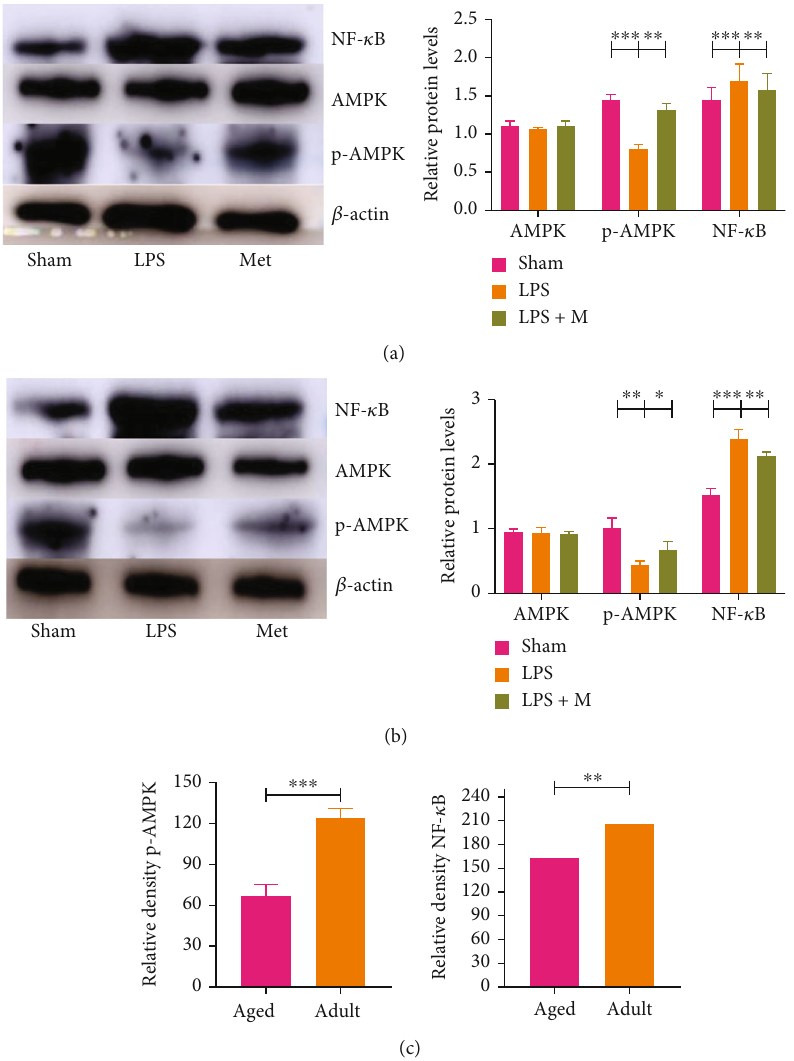
Figure 7: (a) and (b) show the e ff ects of metformin on AMPK, p-AMPK, and NF- κ B protein levels in LPS-induced SAE mice brain tissues in adult and aged groups, respectively. (c) Comparison of LPS-induced SAE mice treated with metformin between the adult group and the aged group LPS + M group. ∗ p < 0 : 05 , ∗∗ p < 0 : 01 , ∗∗∗ p < 0 : 001 . n = 10 in each group. AMPL: adenosine 5 ′ -monophosphate- (AMP-) activated protein kinase; p-AMPK: phosphorylation adenosine 5 ′ -monophosphate- (AMP-) activated protein kinase; NF- κ B: nuclear factor